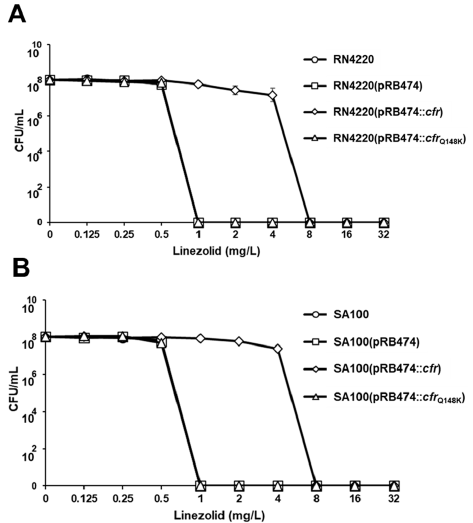
Figure 1. Linezolid population analyses in cfr transformants of RN4220 ( A ) and SA100 ( B ) strains. AUC values of RN4220 and SA100 strains expressing the wild-type cfr were 44.12 ± 1.48 and 45.69 ± 0.48, respectively. AUC values of RN4220 and SA100 strains expressing cfr Q148K were 5.95 ± 0.03 and 5.90 ± 0.04, respectively.